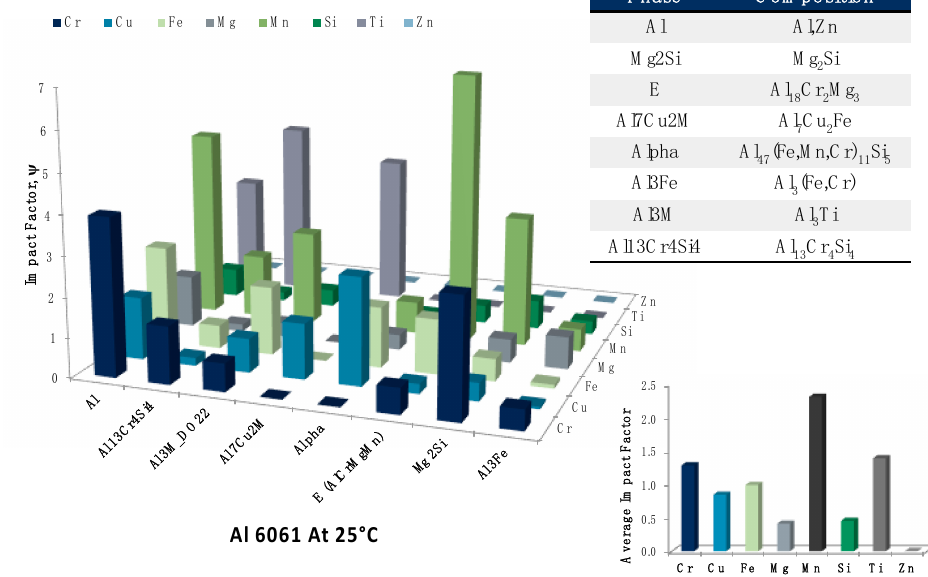
Figure 24. Presentation of the temperature associated with the known phenomena of natural aging in lightweight aluminum alloys. Once again, under equilibrium conditions, one may note that manganese, titanium and chromium maintained the greatest average 𝜓 s associated with equilibrium phases at 25 °C, whereas zinc, magnesium, and silicon, maintained the least impactful average 𝜓 s.